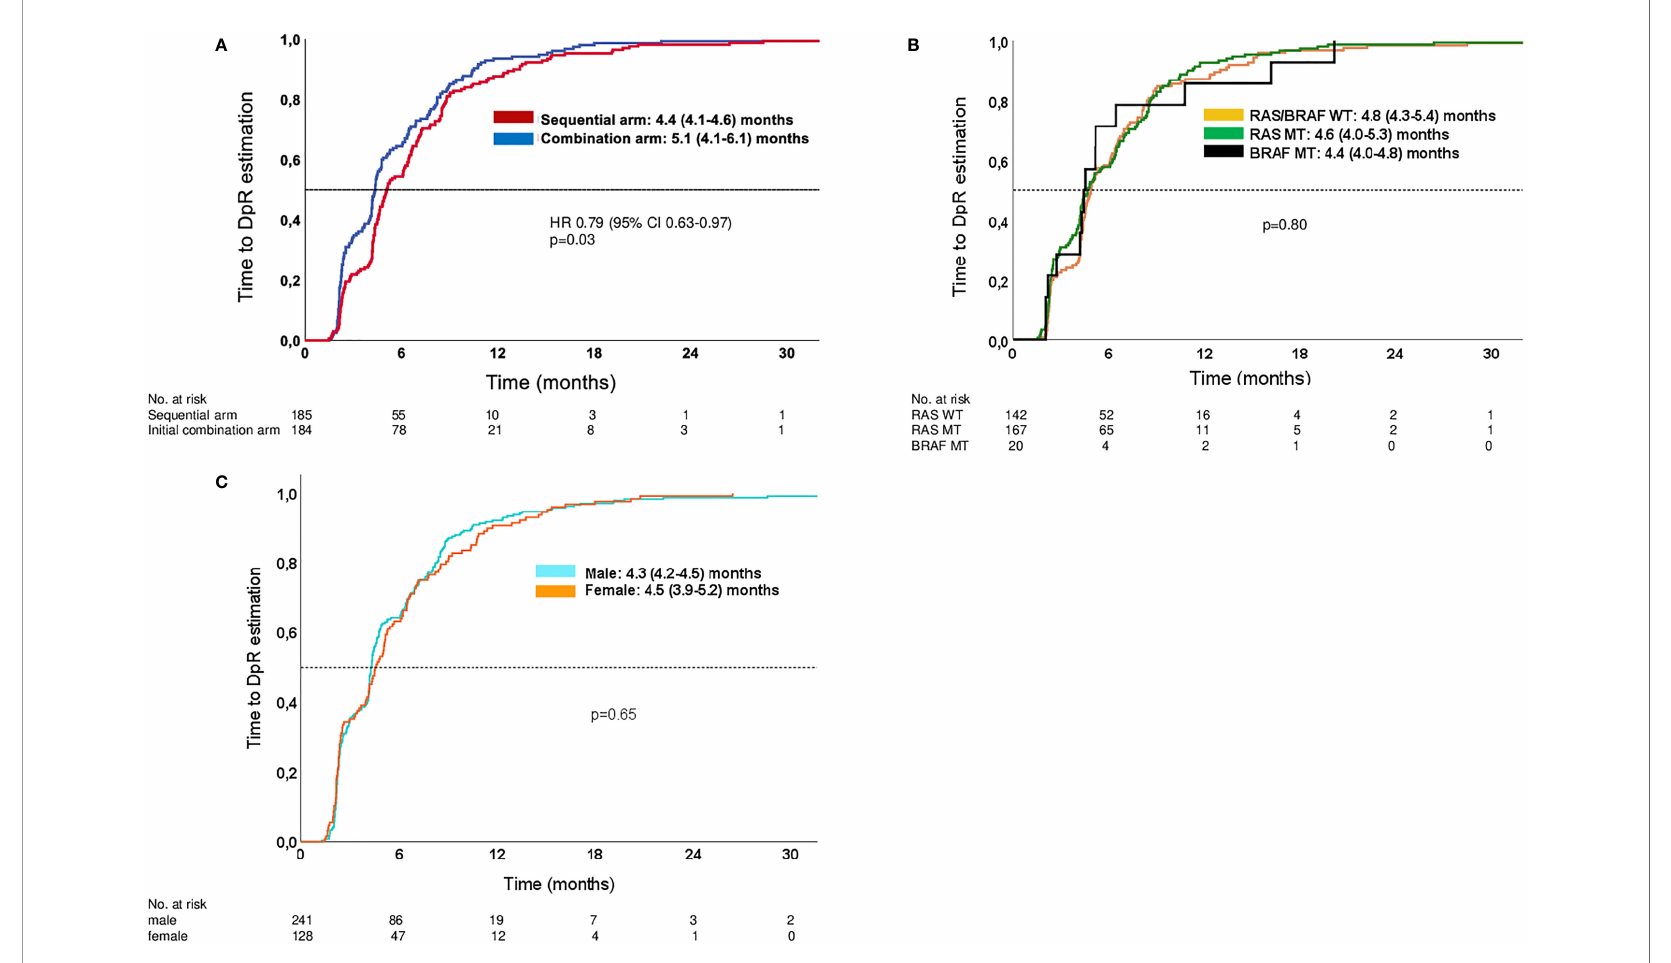
FIGURE 2 | Kaplan – Meier estimates of time to DpR. (A) Time to DpR in study arms. (B) Time to DpR in molecular subgroups (both arms of study). (C) Time to DpR in male and female patients (both arms of study). Analyses are limited to patients with a DpR of at least 0% (no change) or reduction in tumor